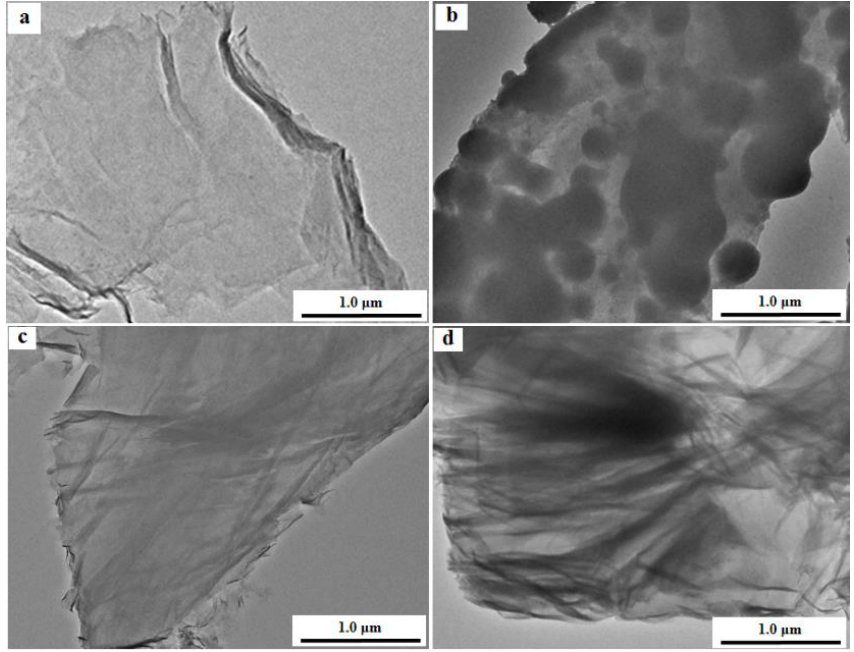
Figure 4. TEM images of ( a ) rGO, ( b ) PZS@rGO4%, ( c ) PZS@rGO8% and ( d ) PZS@rGO12%.